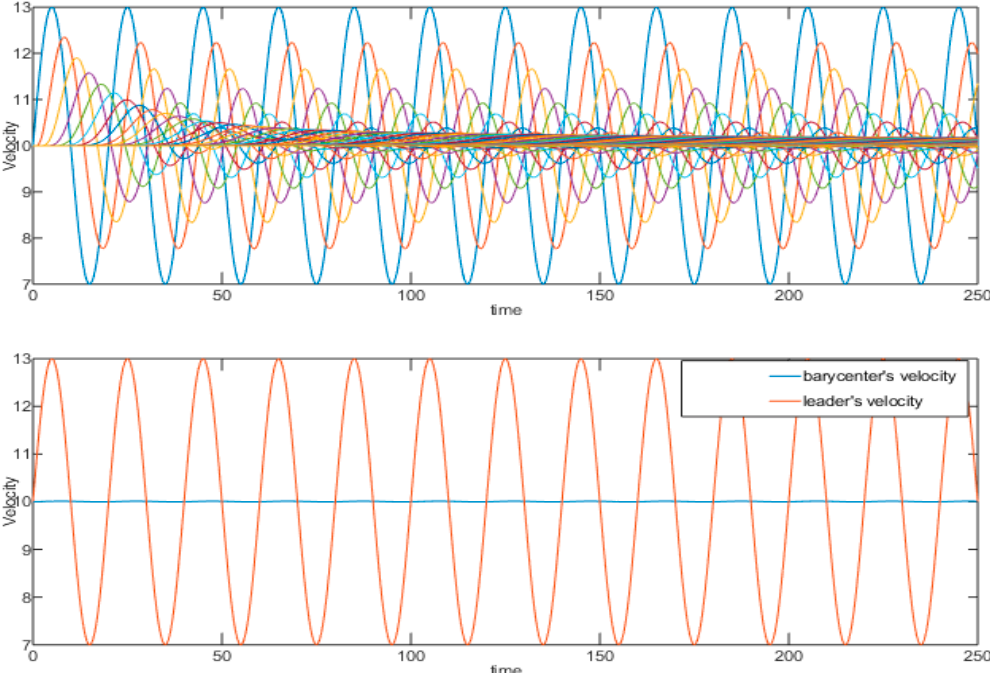
Figure 9. The standard model simulated with 500 vehicles excited by the harmonic perturbation of the Leader’s velocity Equation (14). On ( top ), the velocity of each vehicle that follows the leader, on the ( bottom ), the velocity of the leader and the one of the barycenter of the system, plotted versus time.